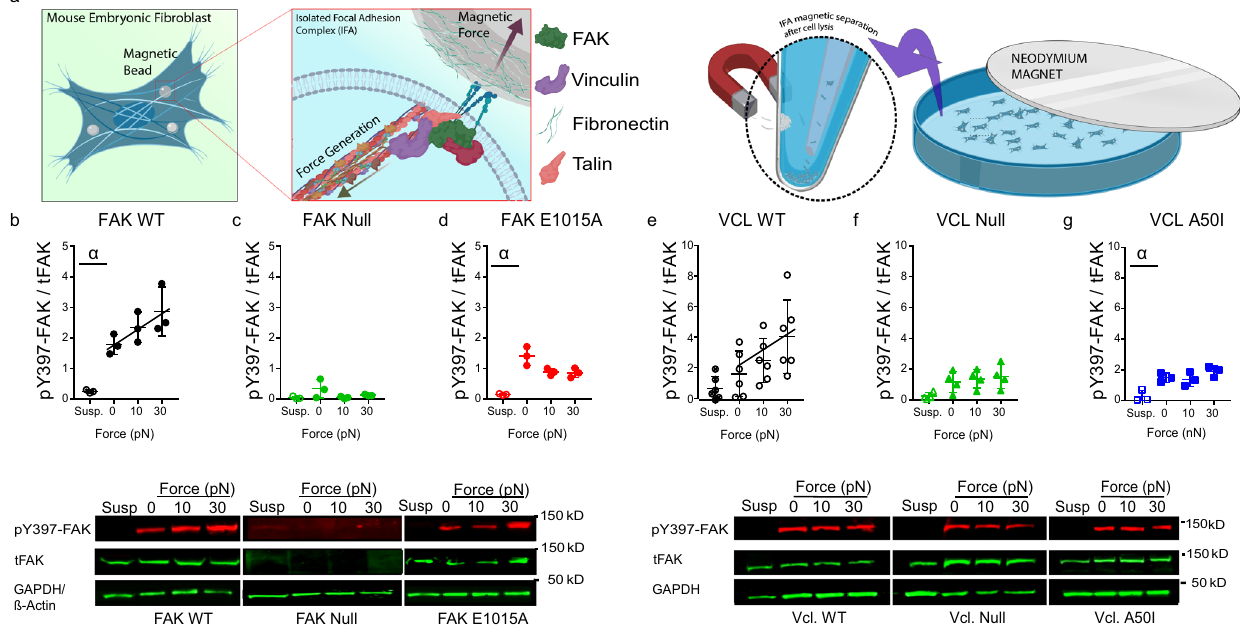
Fig. 4 FAK phosphorylation increases linearly with applied force. a Schematic of application of external force to integrin-based FAs and isolation of FAs using magnetic beads. b-d , pY397-FAK/tFAK levels for FAK-null cells expressing FAK constructs (top) and Western blots (below). b For WT FAK- expressing cells, pY397-FAK/tFAK levels (mean ± SD) increase linearly with applied force. Linear regression ( P = 0.0489, pY397-FAK/FAK = 0.0345 × force + 1.870). t -test α : P = 0.0013, n = 3 independent experiments. c For FAK-null cells, background levels of pY397-FAK/tFAK (mean ± SD) are